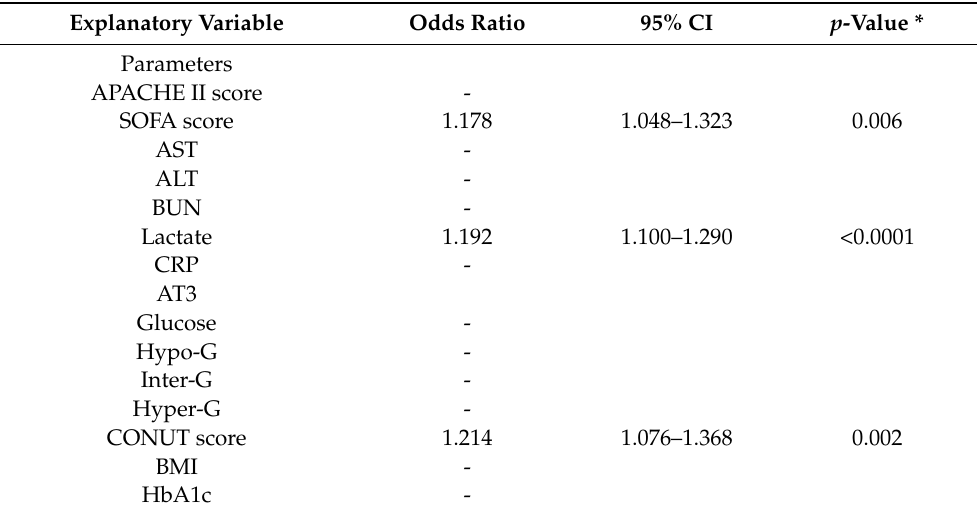
Table 3. Independent predictors of